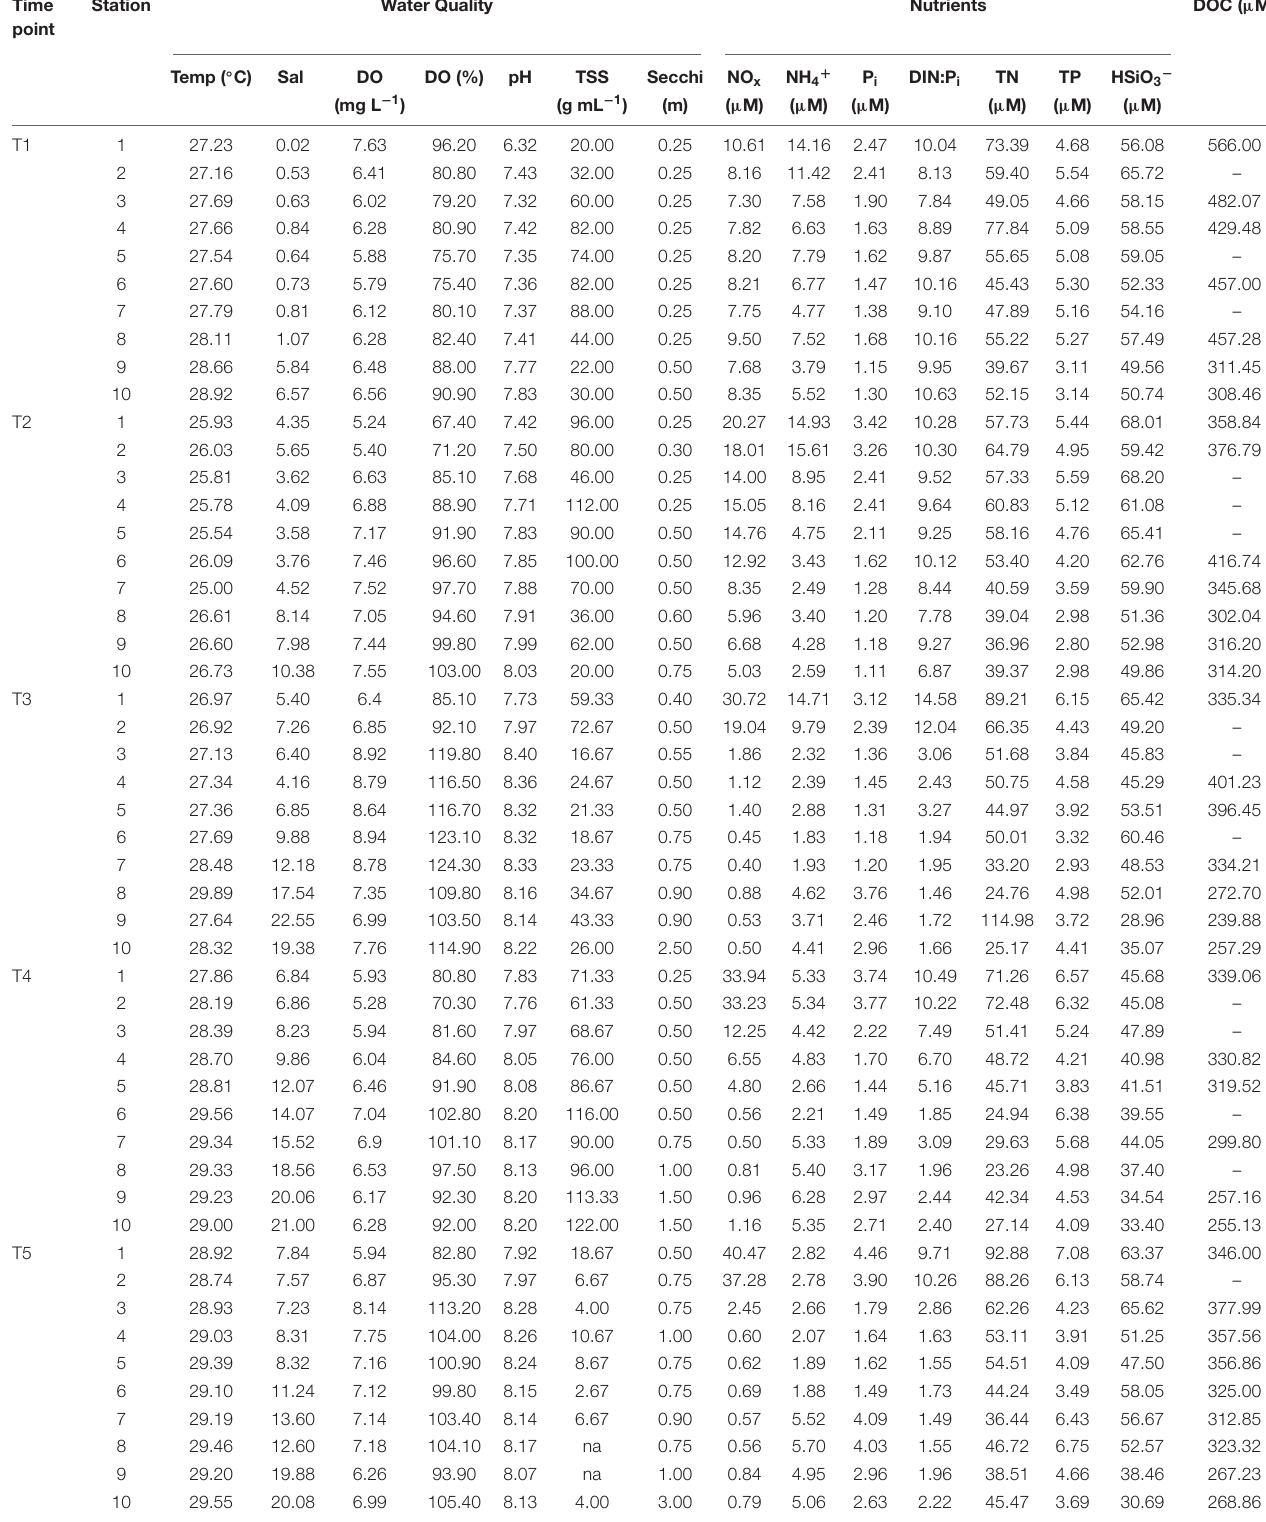
TABLE 1 | Water quality parameters that were measured at each stations during each time